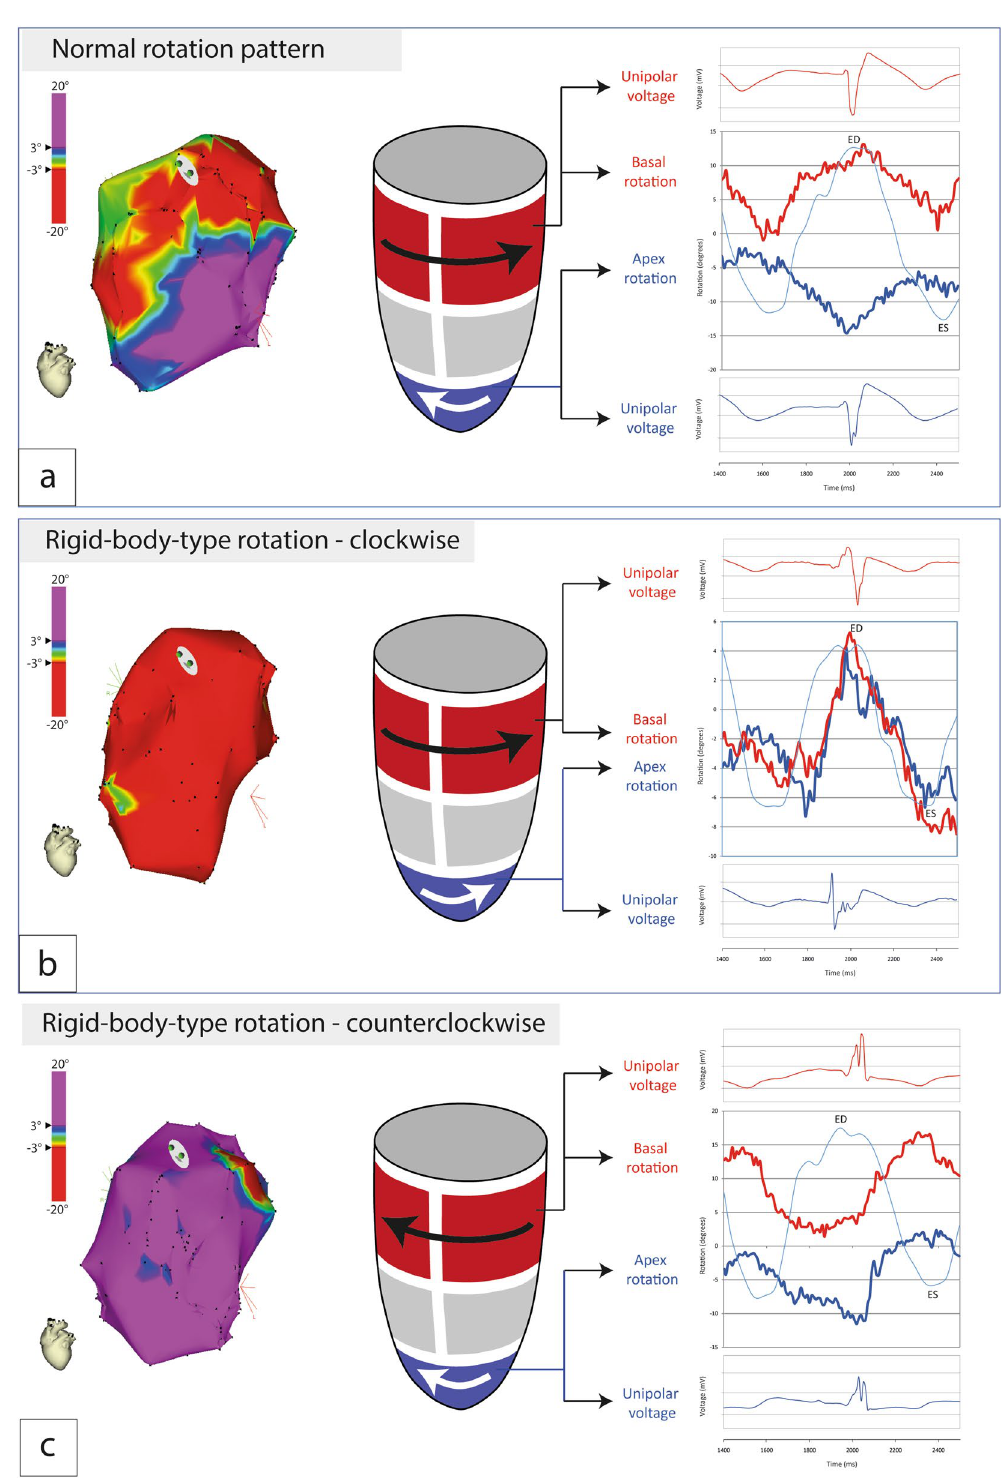
Figure 2. Left ventricle rotation patterns in patients with HFrEF and LBBB. ( a ) Apex–basal mechanical and electrical function in patient with wringing rotation pattern (characteristic for healthy individuals and observed in a subgroup of LBBB patients). ( b ) Apex–basal mechanical and electrical function in patient with predominantly clockwise rotation pattern. ( c ) Apex–basal mechanical and electrical function in patient with predominantly counterclockwise rotation pattern. Red areas indicate clockwise rotation (> 3°); Purple areas indicate counterclockwise rotation (<